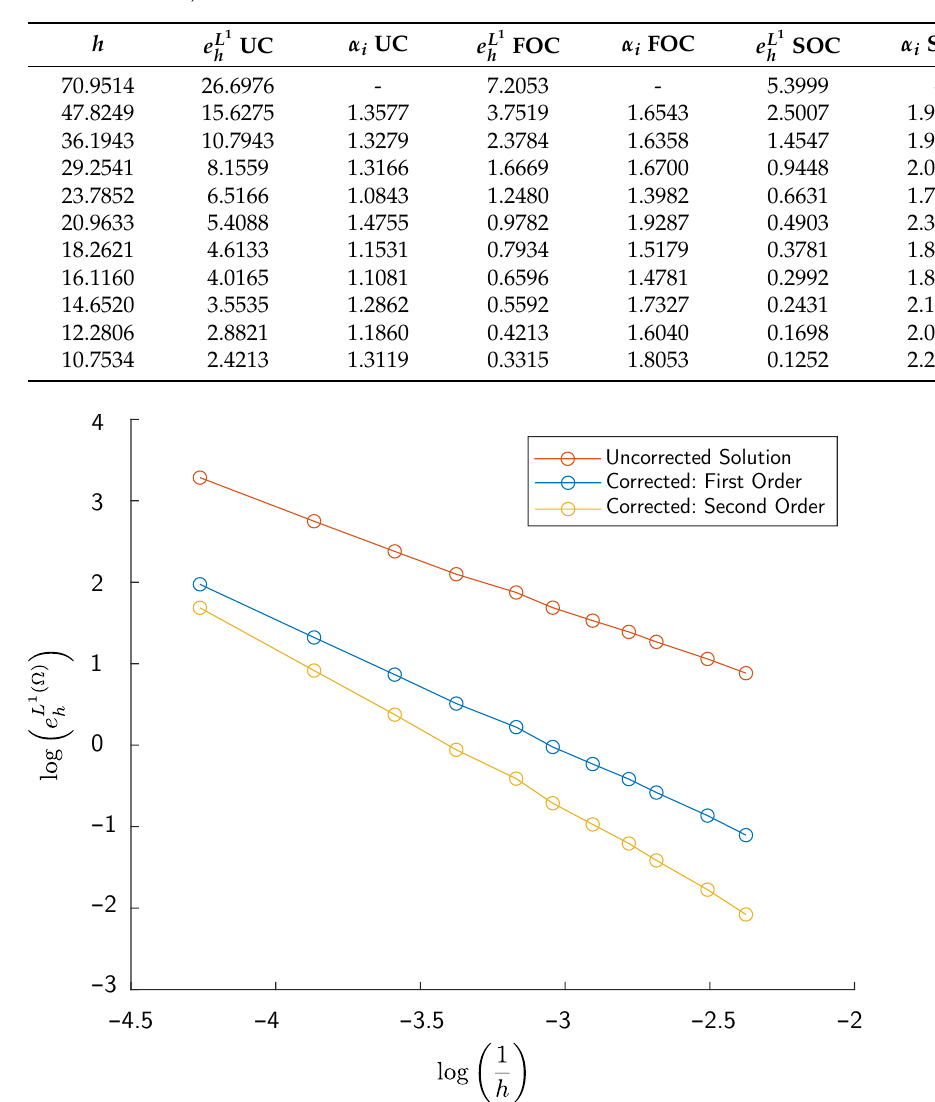
Table 2. Convergence analysis results (UC:Uncorrected; FOC:First Order Corrected; SOC: Second Order Corrected).